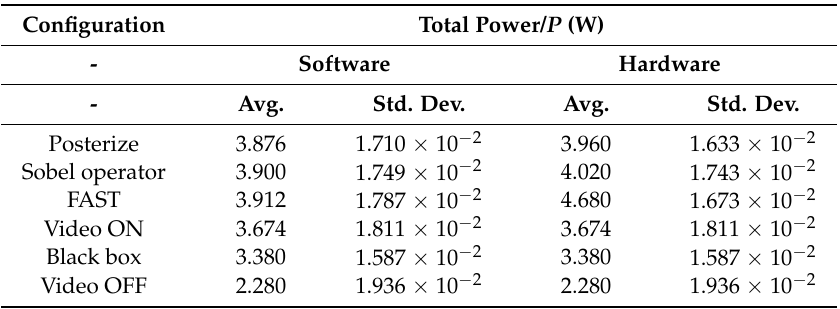
Table 1. The software/hardware total power consumption (average and standard deviation values) of the proposed configurations.